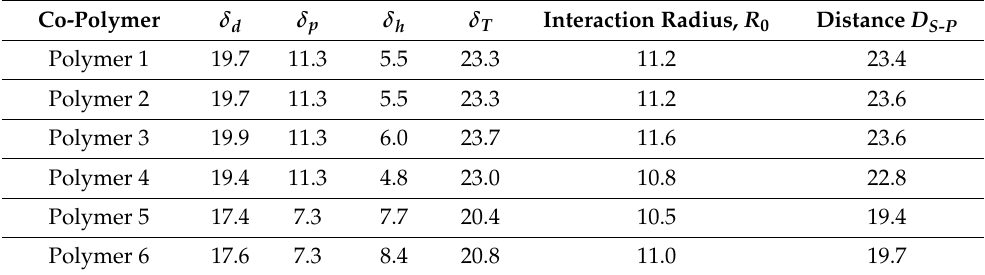
Table 6. Hansen parameters, interaction radius ( R 0 ) and the distance ( D S-P ) at collapse composition for Polymers